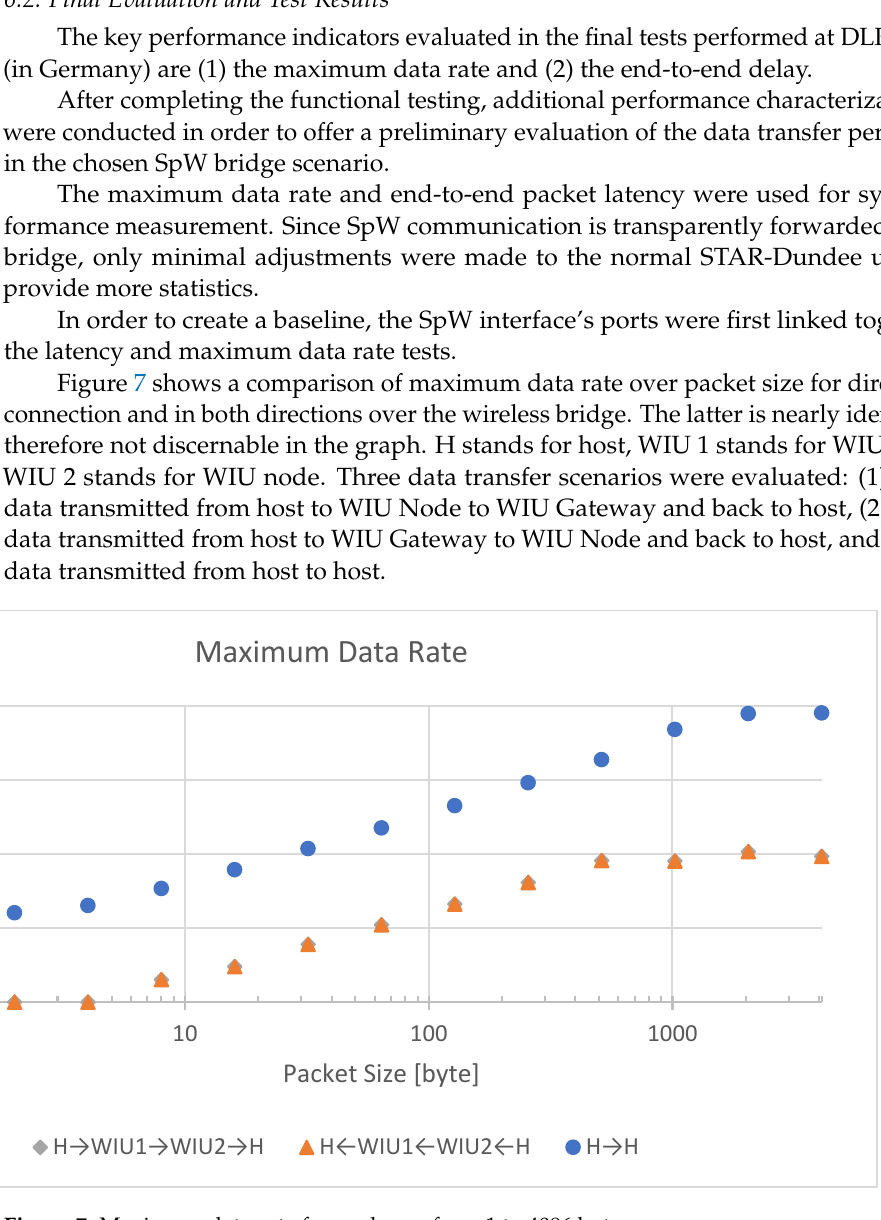
Figure 8. Packet latency for a direct host-to-host connection. The same effect can be observed in the latency measurements for data transmission over the wireless bridge. Dedicated measurements were taken for both directions of the bridge, which are shown in Figures 9 and 10.